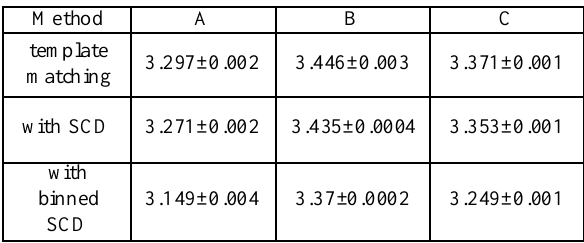
Table 1. Age estimates for test regions A, B and C.